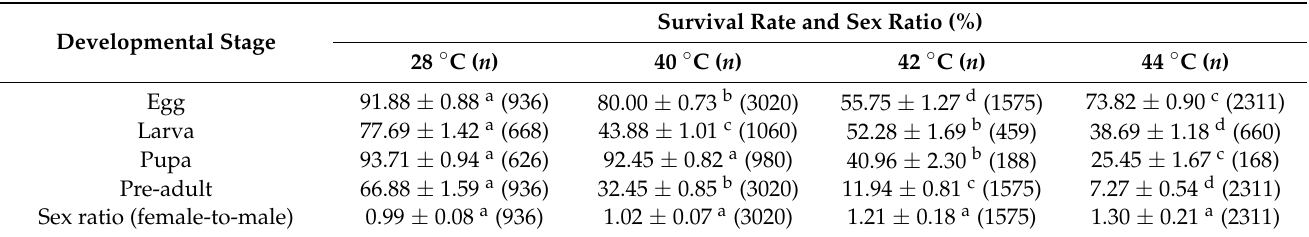
Figure 2. The age-specific survival rate ( s xj ) of Ophraella communa exposed to different stressful high temperatures. ( A ): 28 ◦ C, ( B ): 40 ◦ C, ( C ): 42 ◦ C, ( D ): 44 ◦ C. Table 3. Effects of periodical high-temperature exposure on the survival rates and sex ratio of different life stages of the ragweed beetle Ophraella communa